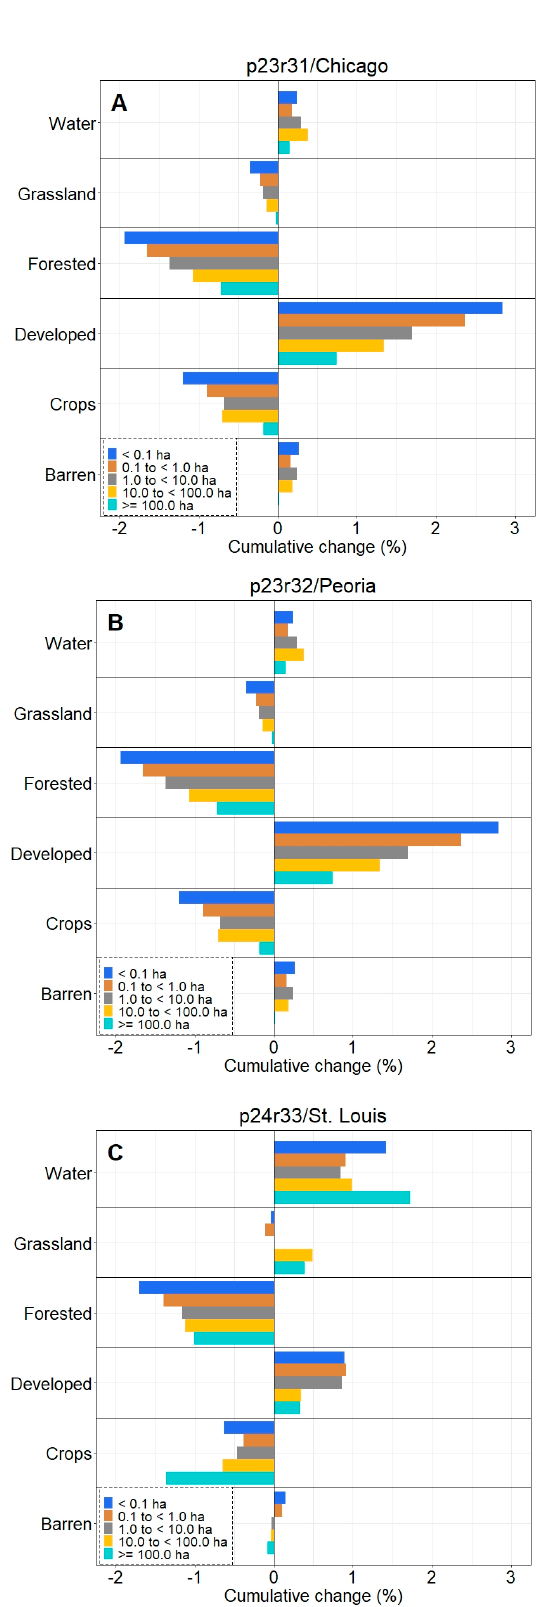
Figure 12. Twenty-five years of LULC change in surface-water buffers binned into five aquatic system size classes across ( A ) Chicago, ( B ) Peoria, and ( C ) St. Louis footprints.